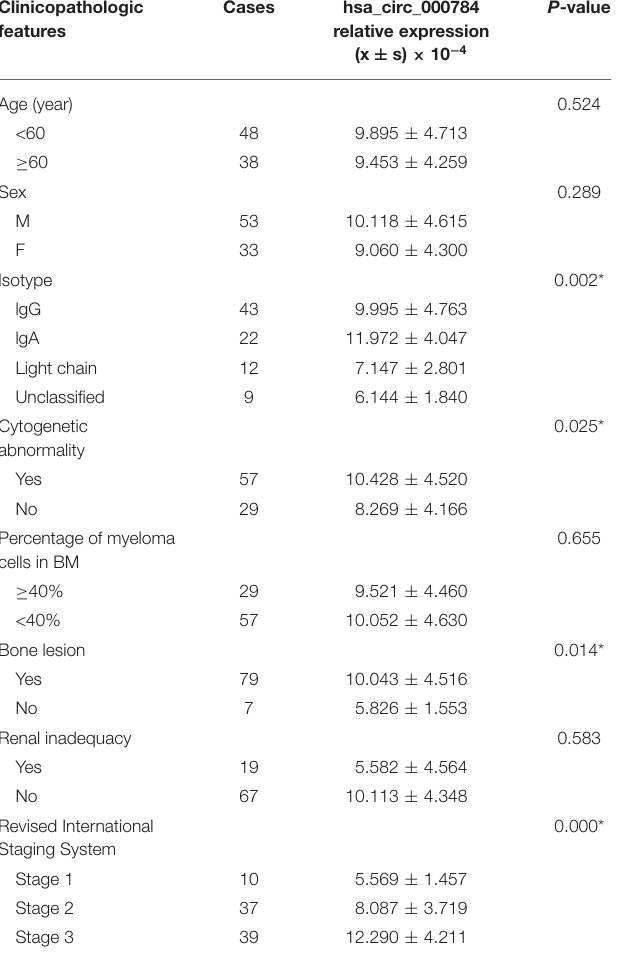
TABLE 2 | Correlations between the relative expression of hsa_circ_0007841 and clinicopathologic features in 86MM patients. Clinicopathologic